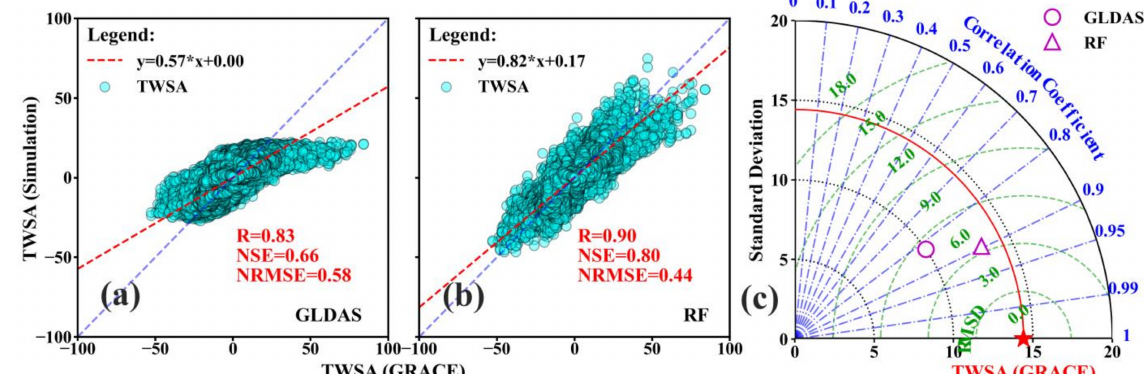
Figure 4. Performance comparison of the GRACE TWSA and simulated TWSA (GLDAS and RF-built TWSA) at the grid scale for 2003–2014. The 1:1 line is blue, and the fitted line is red. ( a ) Scatter plot of the GLDAS TWSA and GRACE TWSA time series; ( b ) Scatter plot of the RF-built TWSA and GRACE TWSA series; ( c ) Taylor diagram for comparing the GRACE TWSA data and the simulated TWSA data.